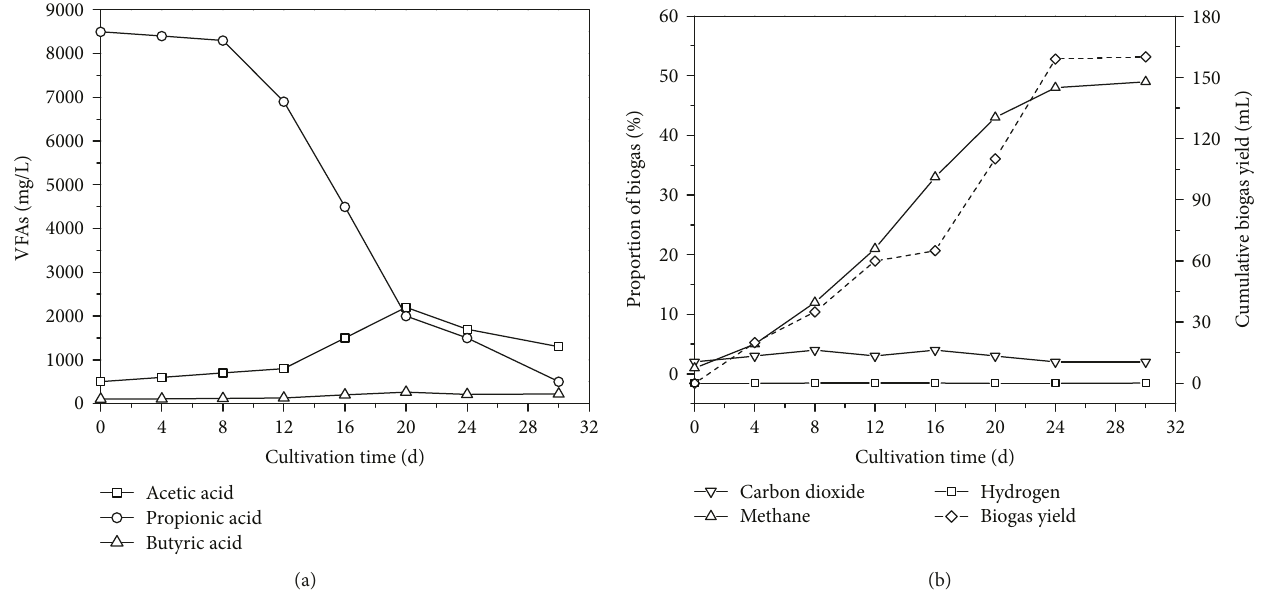
Figure 1: Performance of Z08 through propionic acid degradation (a) and methane production